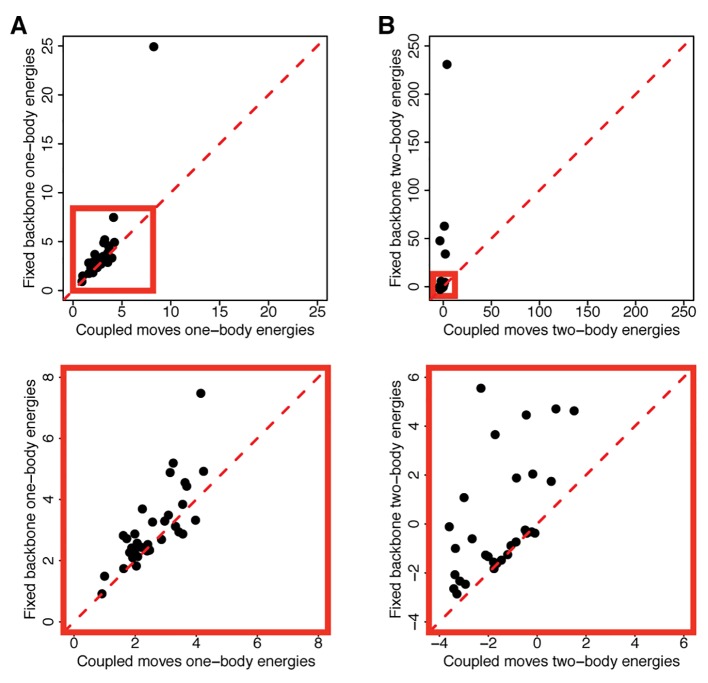
Comparison of the predicted energetic effects of the specificity altering mutations between the fixed backbone and coupled moves methods.Predicted energies (in Rosetta energy units) for each of the specificity altering mutations for A) one-body interactions and B) two-body interactions of the residue at the mutated position. Scatterplots show a comparison of energies from fixed backbone and coupled moves methods, where each dot denotes a mutation and y = x is shown as a dashed red line. Data points above the diagonal indicate larger (more unfavorable) predicted energies using fixed backbone design. The bottom scatterplots show close-ups of the plot area within the red boxes in the top scatterplots.